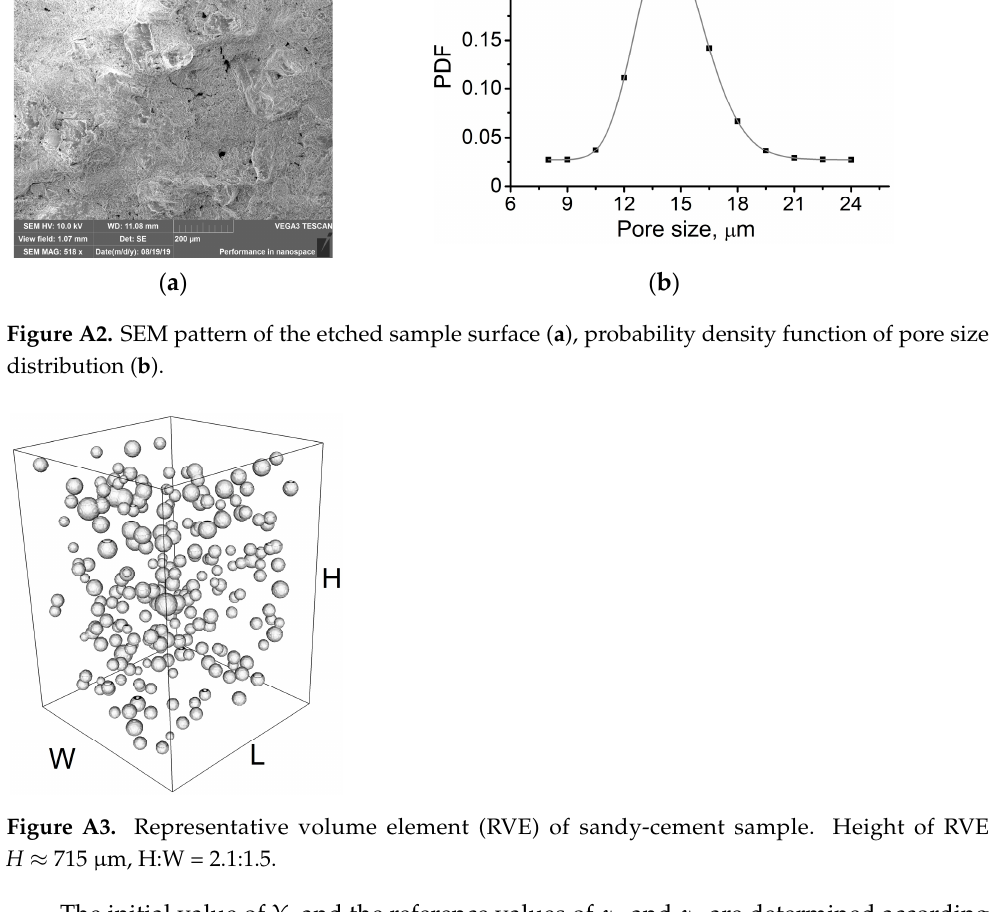
Figure A3. Representative volume element (RVE) of sandy-cement sample. Height of RVE H ≈ 715 µm , H:W = 2.1:1.5.